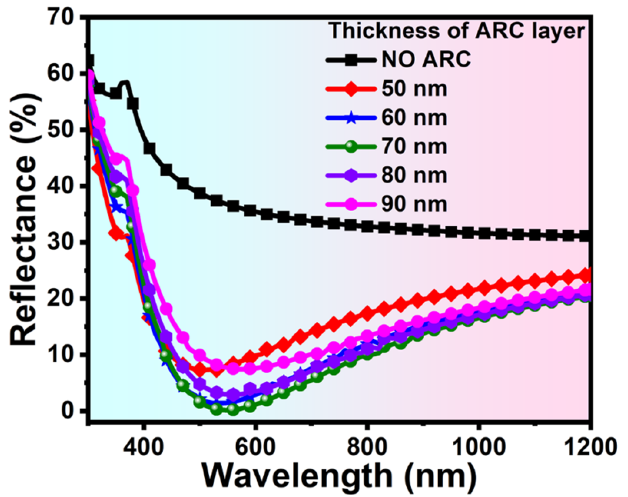
Figure 6. Simulated reflectance analysis of HfO 2 ARC layer-based c-Si solar cell. Table 2. Photovoltaic parameters of HfO 2 ARC-based c-Si solar cell.